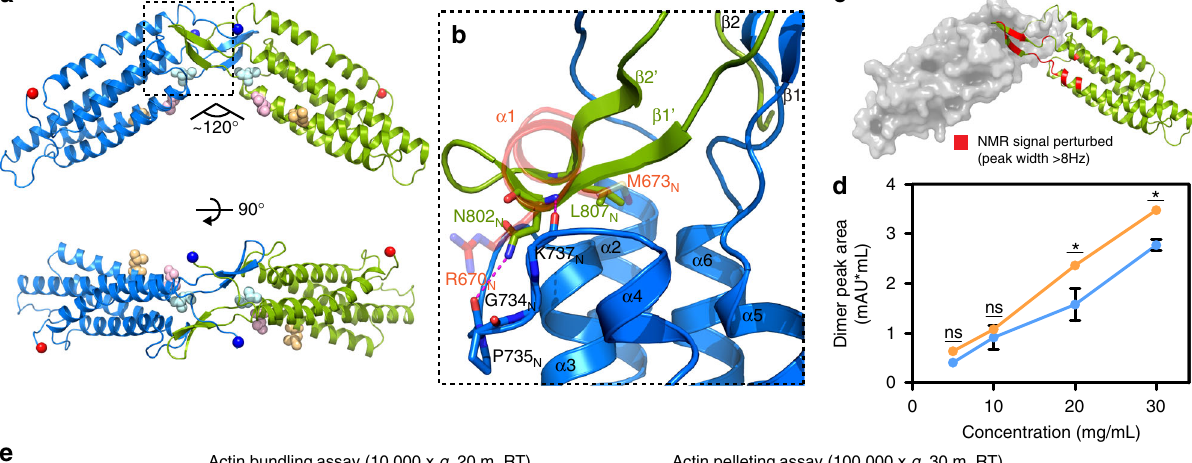
displayed punctate AJs connected to actin cables aligned along the wound edge, whereas α Ecat-H1 cells formed less organized punctate AJs and actin assemblies (Fig. 3c and Supplementary Fig. 9a). High-resolution live-imaging revealed that α Ecat-H1 AJs were less organized towards the wound front, resulting in unproductive cell-cell tugging events that appeared to interfere